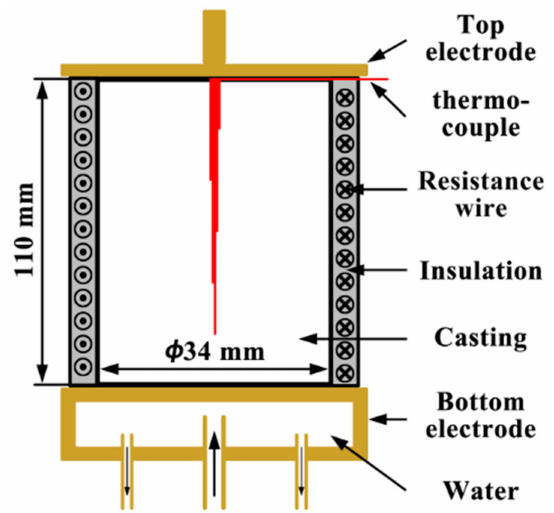
Figure 1. Schematic sketch of the experimental apparatus for directional solidification of Al-7Si